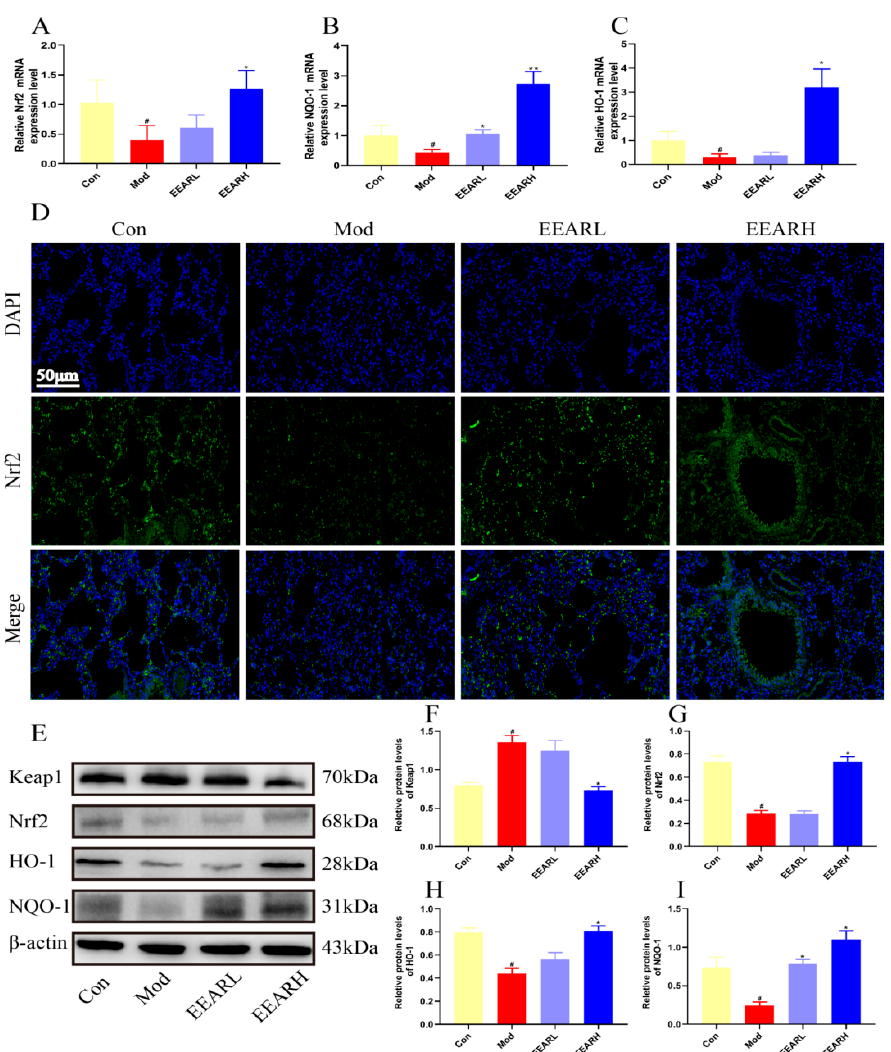
Figure 6. EEAR reduced oxidative stress levels in rats with ALI via the Keap1/Nrf2 signaling pathway. The relative expression of ( A ) Nrf2, ( B ) NQO-1, and ( C ) HO-1 in the lung tissue of rats was evaluated by RT-qPCR ( n = 6). ( D ) Immunofluorescence of Nrf2 protein in rat lung tissue. ( E ) Keap1/Nrf2 signaling pathway expression levels in rat lung tissue were measured by Western blot analysis ( n = 3). ( F ) Quantitative analysis of differences in Keap1 levels in each group ( n = 3). ( G ) Quantitative analysis of differences in Nrf2 levels in each group ( n = 3). ( H ) Quantitative analysis of differences in HO-1 levels in each group ( n = 3). ( I ) Quantitative analysis of differences in NQO-1 levels in each group ( n = 3). Values are expressed as means ± SEM. # p < 0.05 vs. Control; ** p < 0.01 vs. Model; * p < 0.05 vs. Model.